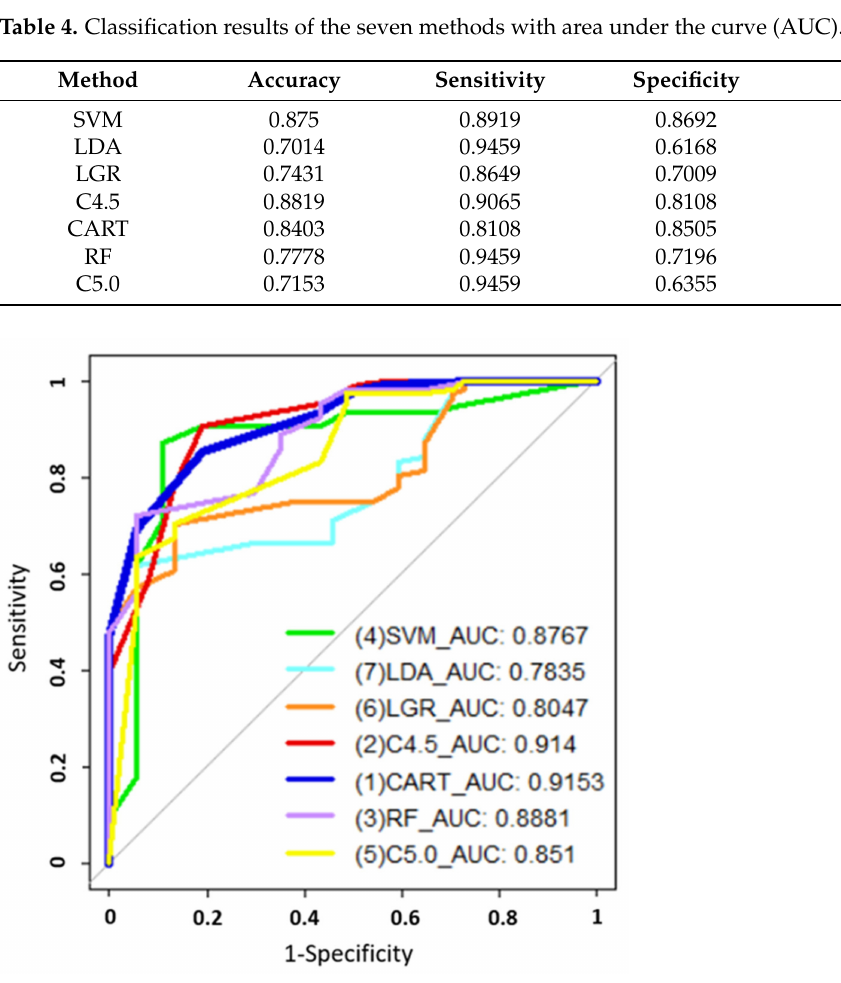
Figure 1. Receiver operating characteristic (ROC) curves of the seven methods with